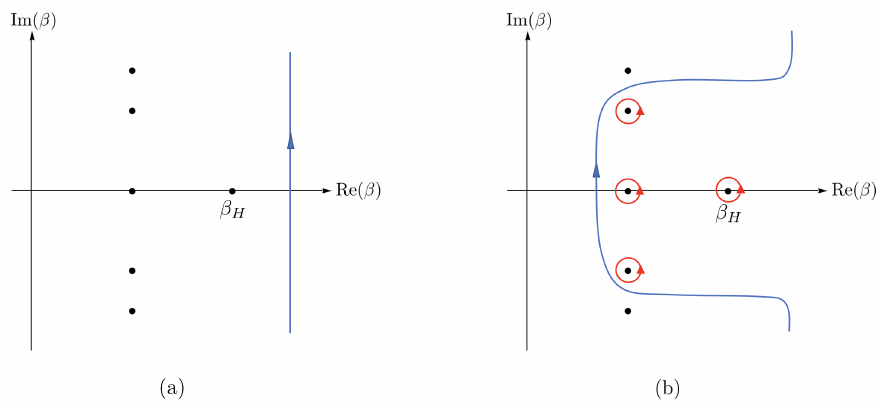
Figure 10 . (a) The original contour for computing ρ ( E ) . (b) One can deform the contour leftwards, and pick up contributions from the complex poles. For example, the pole at β H simply gives the Hagedorn density of